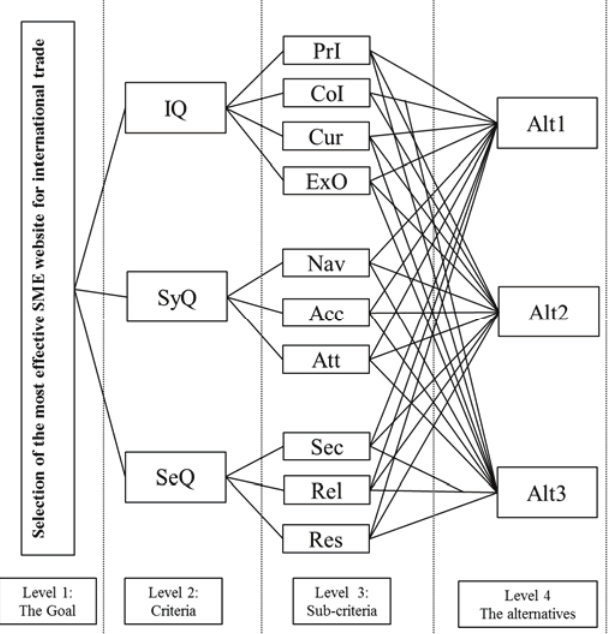
Figure 1. Hierarchy of the AHP